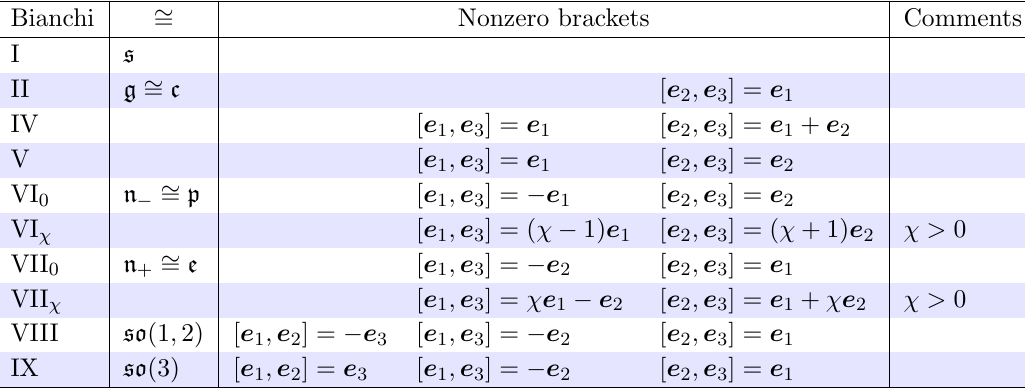
Table 11 . Kinematical Lie algebras for D =